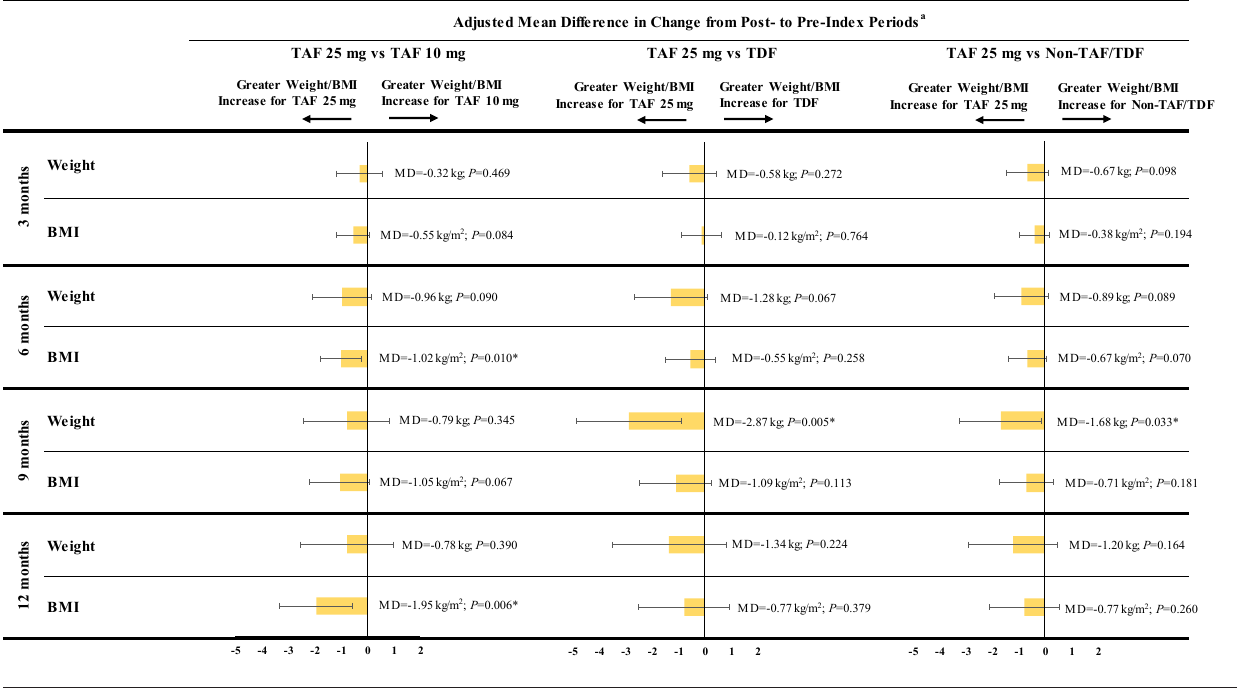
Figure 2. Comparison of Mean Weight or BMI Change Between Pre-index and Post-index Periods